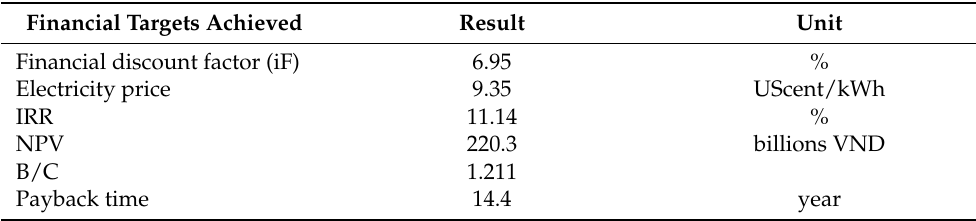
Table 7. Financial analysis